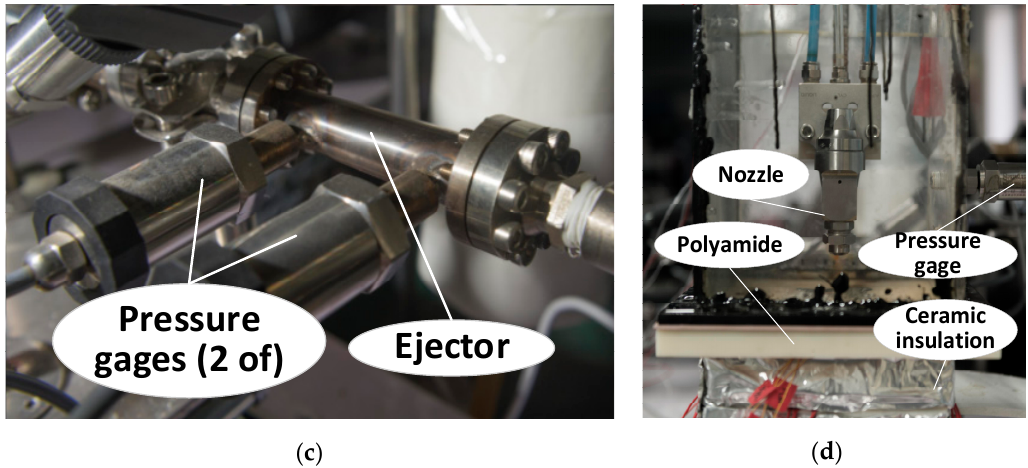
Figure 2. The ground-based experimental setup: ( a ) schematic view of the system, ( b ) spray control device, ( c ) two-phase ejector, and ( d ) spray chamber.